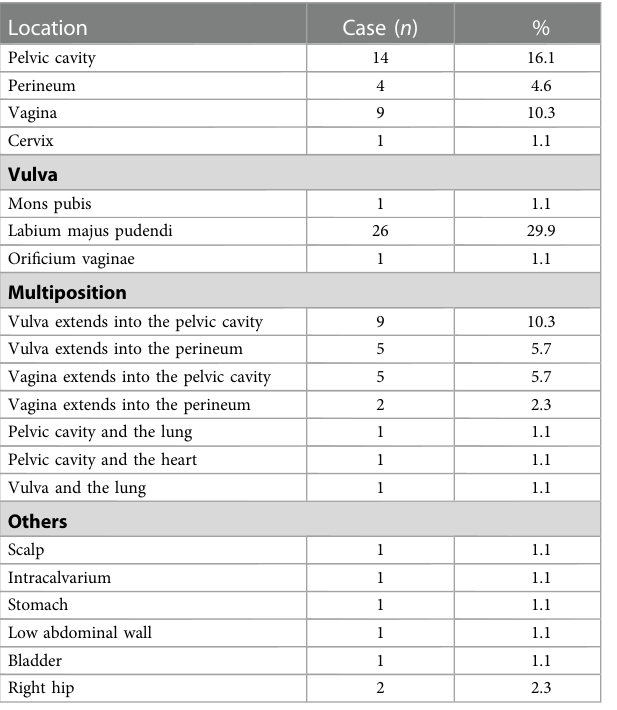
right vulva. There were 22 patients (56.4%) who suffered left vulva